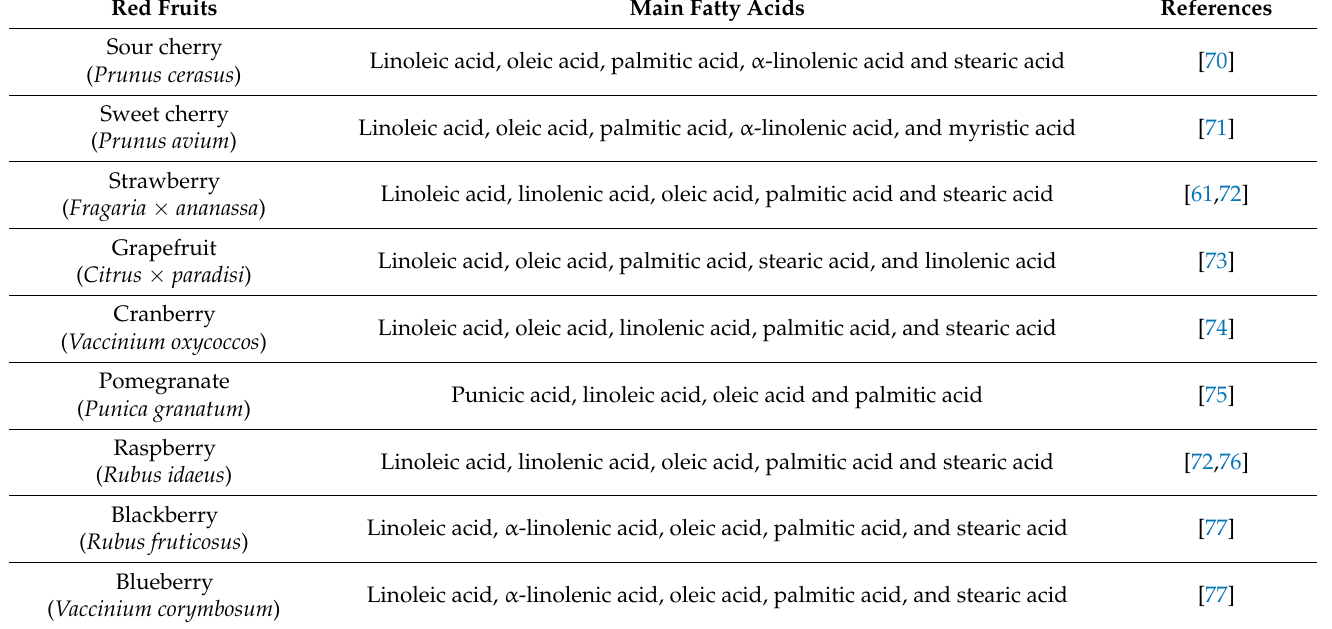
Table 6. Predominant fatty acids in the seed oil of several red fruits. Main Fatty